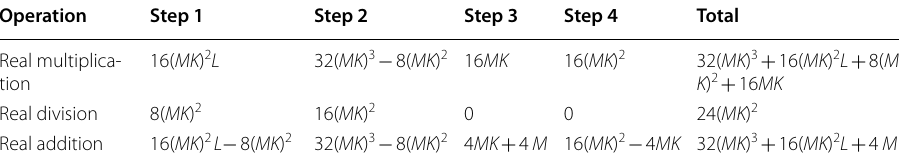
Table 3 Computational complexity of the APSA-STPAP algorithm Operation Step 1 Step 2 Step 3 Step 4 Total Real multiplication 4( MK ) 2 L 4( MK ) 3 Real division 2( MK ) 2 4( MK ) 2 Real